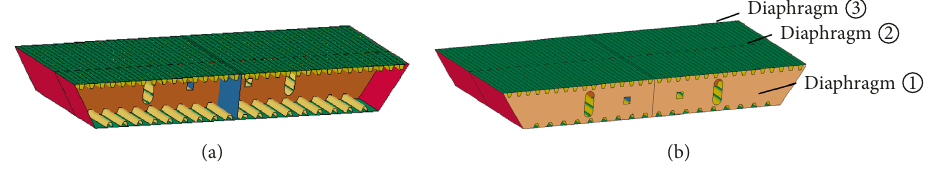
Figure 6: Finite element models. (a) 1/2 girder. (b) 2/3 girder.